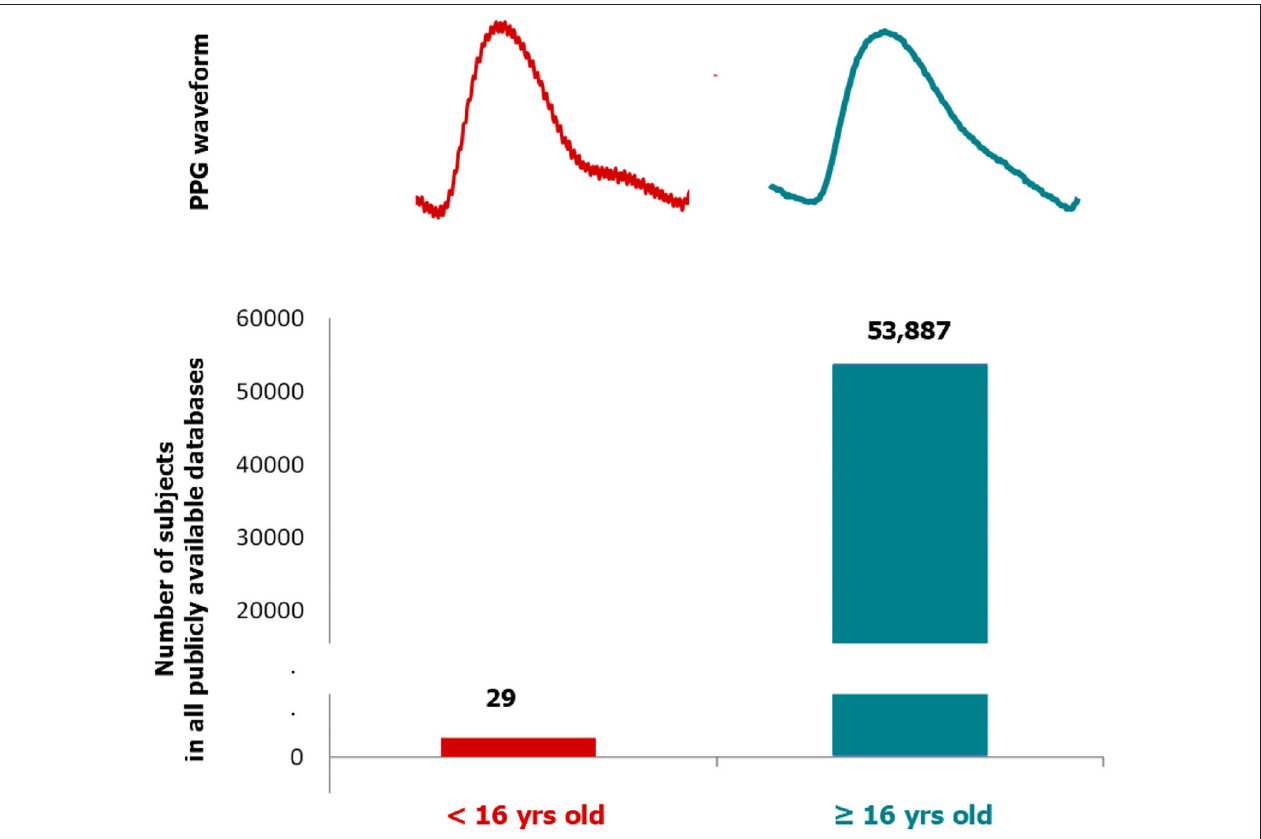
FIGURE 1 | Number of subjects in publicly available pulse oximeter databases according to two age groups: children ( < 16 years) and adult ( ≥ 16 years). Two examples of photoplethysmogram waveforms collected via fingertip pulse oximetry probe (left: 15 years old and right: 50 years old) is shown for each age group. Note that the dicrotic notch is more salient in children compared to adults (i.e., the pulse becoming more triangulated with age).